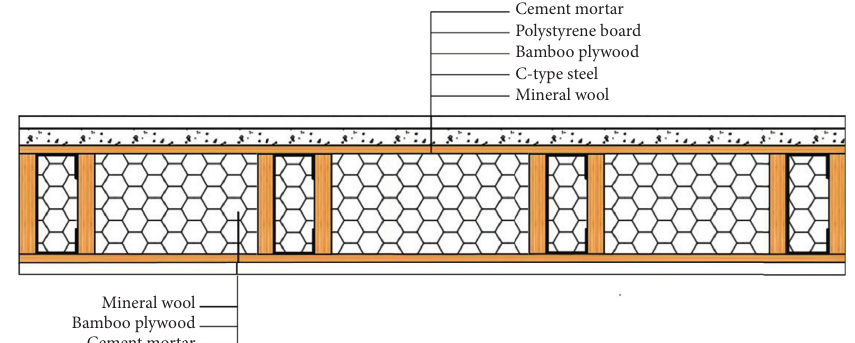
Figure 4: Construction of the composite wall.